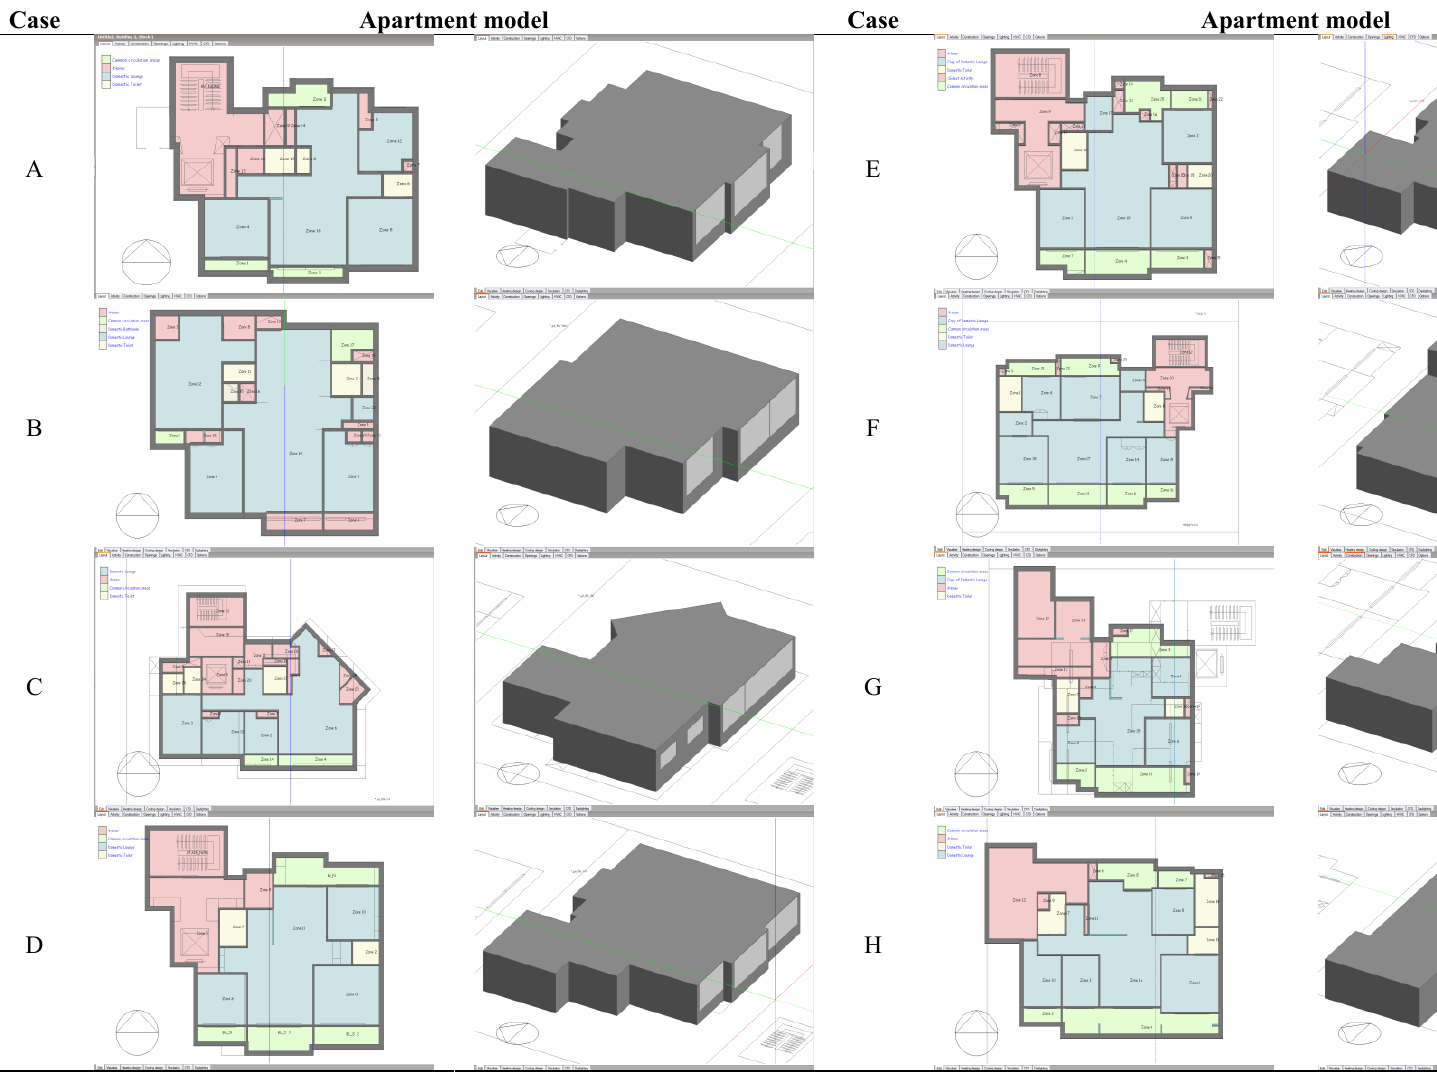
Table 13. Simulation models of a Korean apartment unit for case